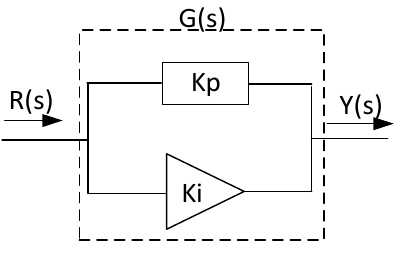
Figure 5. PI regulator structure.